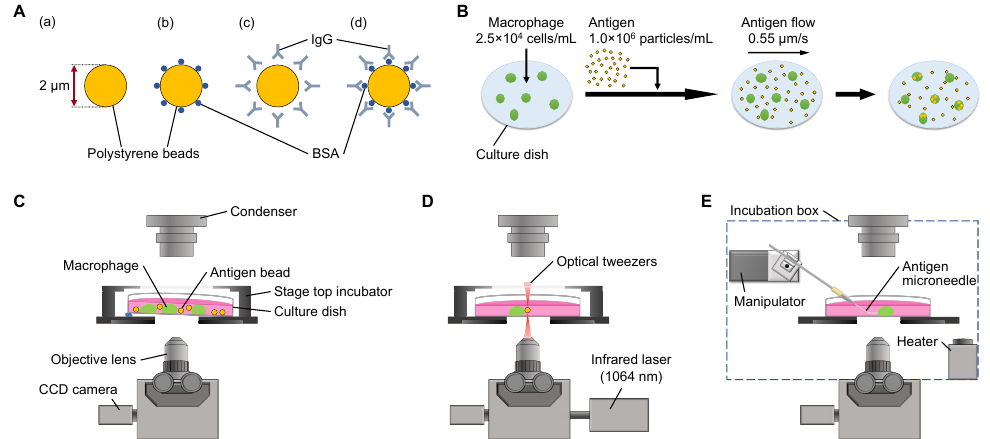
Figure 1. Four kinds of antigen bead and measurement methods for antigen bead and micronee- dle phagocytosis . ( A ). Schematic drawings of samples: ( a ) polystyrene (PS) bead, ( b ) BSA-PS bead, ( c ) IgG-PS bead, ( d ) IgG/BSA-PS bead. ( B ). Procedure of antigen bead phagocytosis experiment by the on-chip free-flow method. Antigen beads were flown in the dish with constant speed to keep the concentration of surrounding macrophages constant. ( C ). Experimental setup for free-flow method. Since macrophages adhered to the bottom of the dish, tilting the dish could generate a flow of antigen beads to the macrophages. ( D ). Experimental setup of bead feeding with optical tweezers. To feed antigen beads one-by-one to macrophages, the beads were trapped and transferred with optical tweezers. ( E ). Experimental setup for IgG/BSA-coated microneedle phagocytosis. The tip of the antigen microneedles was brought into contact with the macrophages by moving the motorized manipulator to which the antigen microneedle was